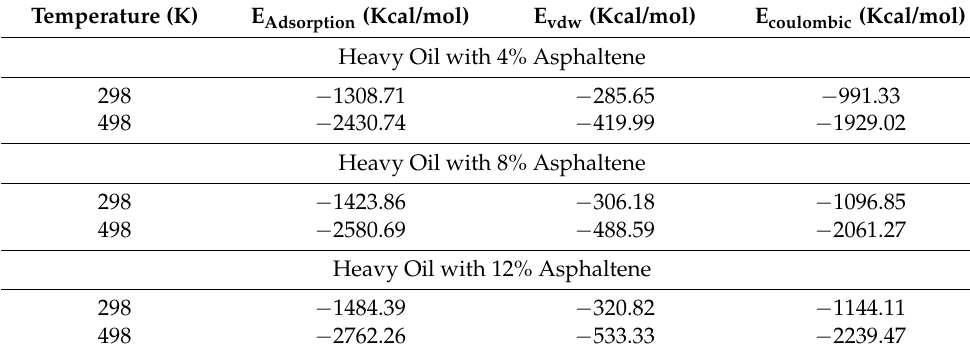
Table 1. Adsorption energy between heavy oil droplets and quartz at 298 K and 498 K.